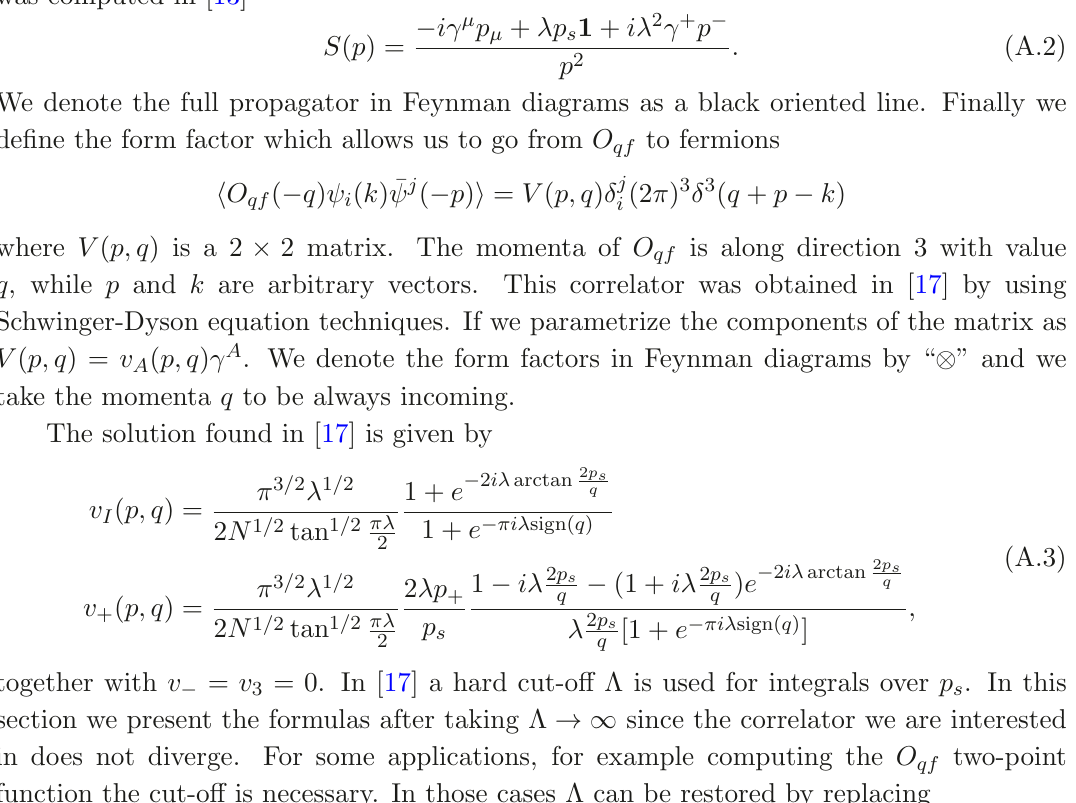
Figure 6 . Vertex corresponding to the form factor between O qf ( ¯ ψ ( p ). For simplicity we omit color indices in the −